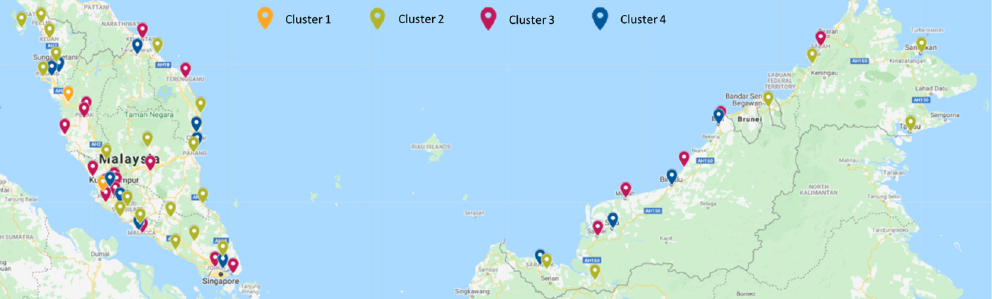
Figure 21. Air monitoring stations’ locations colored according to clusters for PM 10 daily maximum time series data with DTW and FKM as its clustering algorithm.